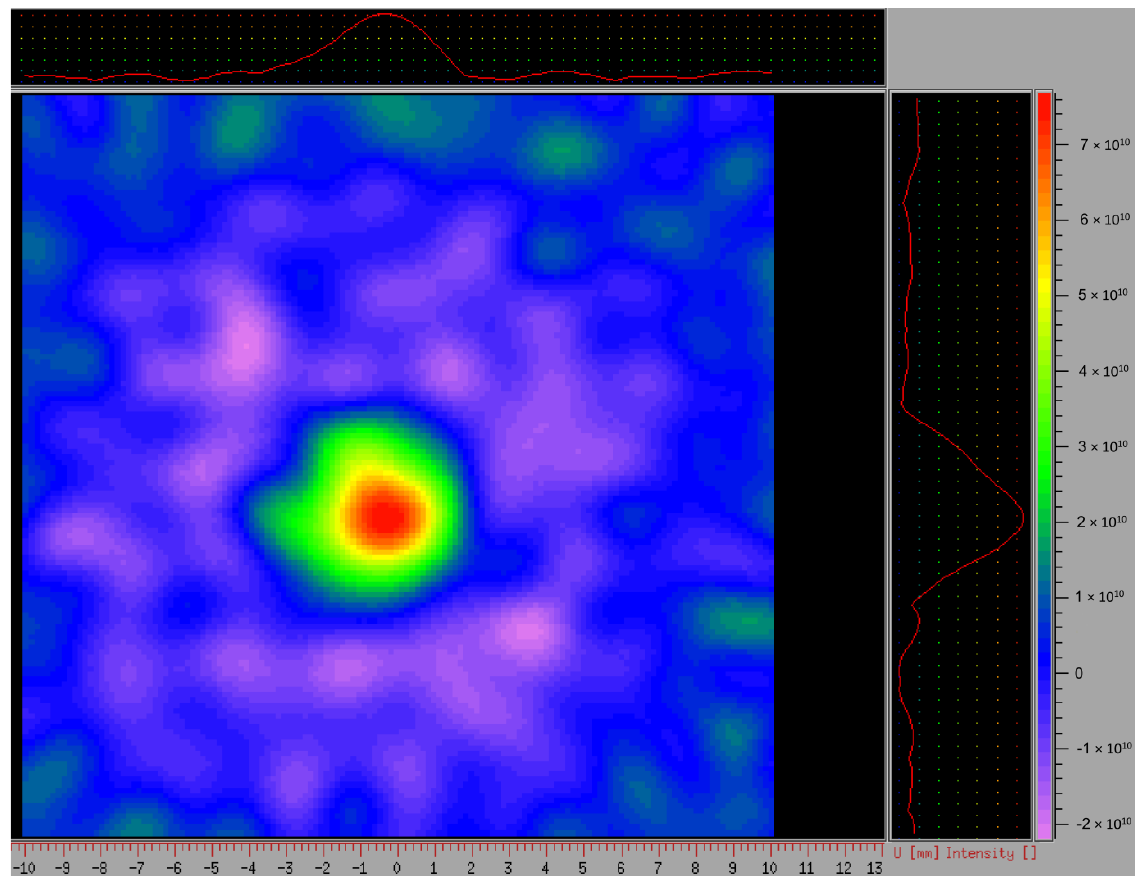
Figure 3. Visualization of the capacity of fresh fruit tissue to reduce spin-probe 3-carbamoyl proxyl (3CP). Two-dimensional EPR image of the Y-Z section.